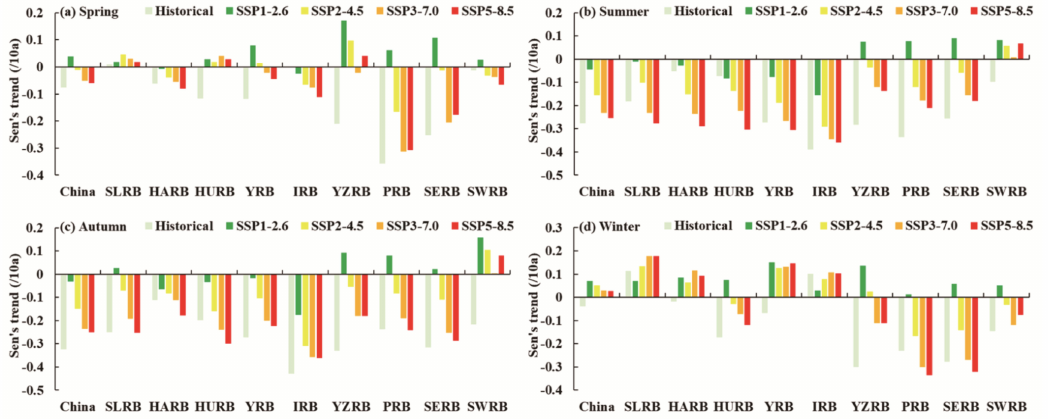
Figure 13. SPEI03-based drought trends in ( a ) spring, ( b ) summer, ( c ) autumn, and ( d ) winter in nine sub-regions. Sen’s trend values were obtained by calculating the mean value of all pixels in nine basin